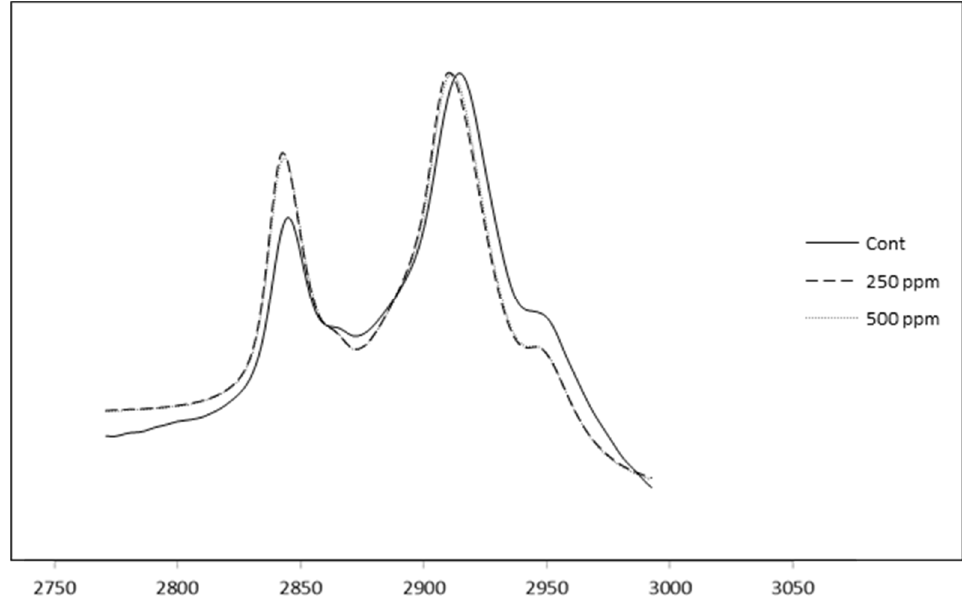
Figure 7. Representative infrared reflection spectra of control and catechin-treated cheese samples. Cont: control full-fat cheese containing no catechin, 250 ppm: full-fat cheese containing 250 ppm of free (+)-catechin, 500 ppm: full-fat cheese containing 500 ppm of free (+)-catechin.